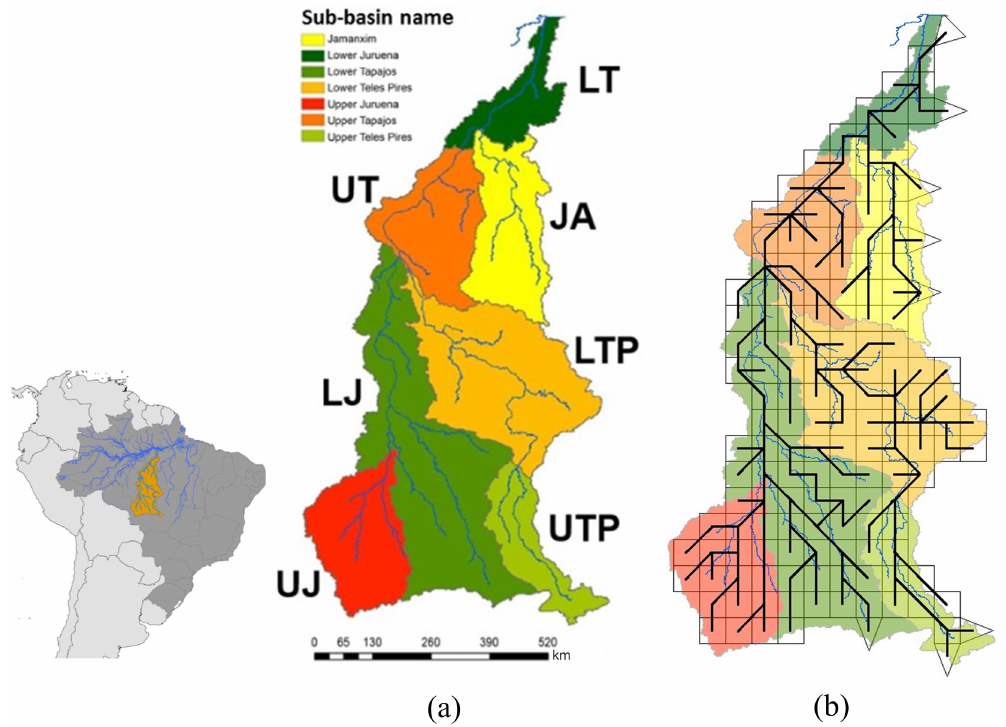
Figure 4. (a) Organization of the Tapajós Basin into seven sub-basins: Upper Juruena (UJ); Lower Juruena (LJ); Upper Teles Pires (UTP); Lower Teles Pires (LTP); Jamanxim (JA); Upper Tapajós (UT); and Lower Tapajós (LT). (b) ED2 + R represents the domain in grid cells with 0.5 ◦ resolution ( ∼ 55km). The black segments indicate the flow accumulation